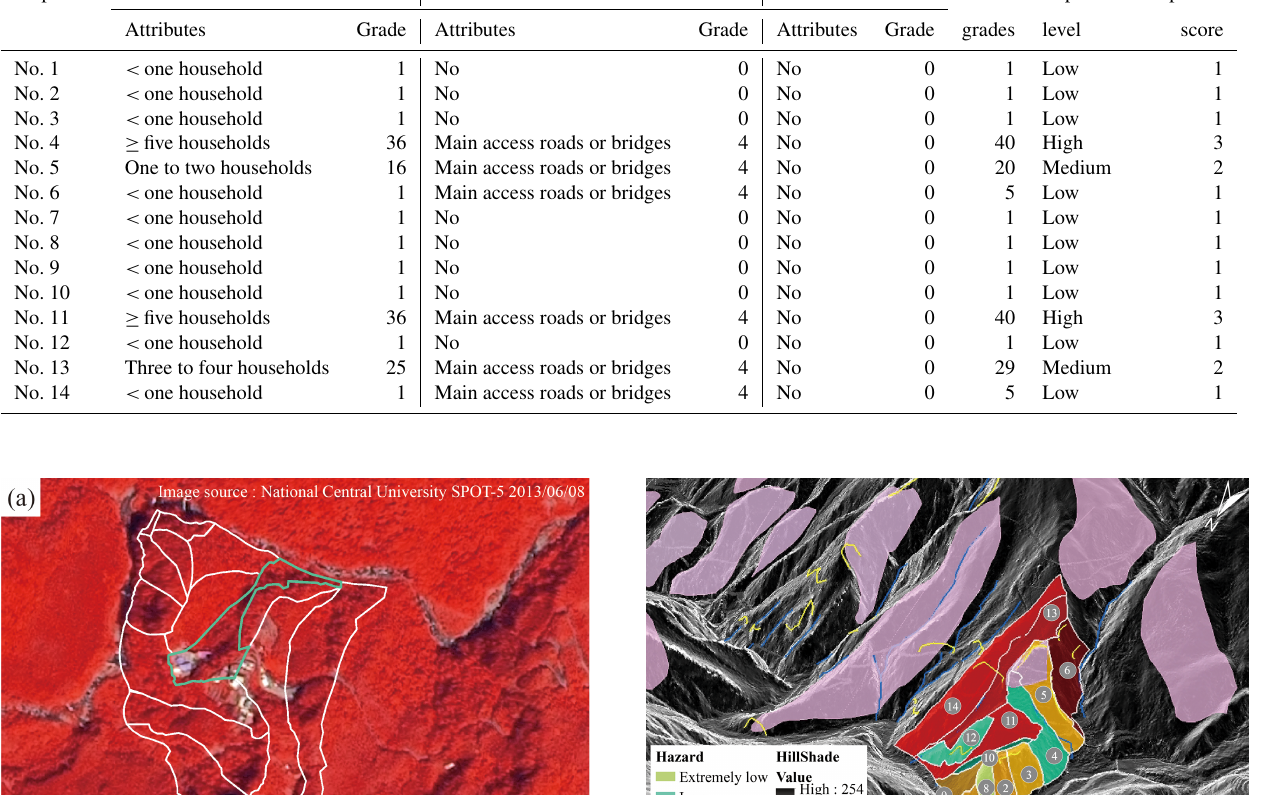
Table 16. Exposure levels and scores of slope units around the Neikuihui tribe. Slope unit